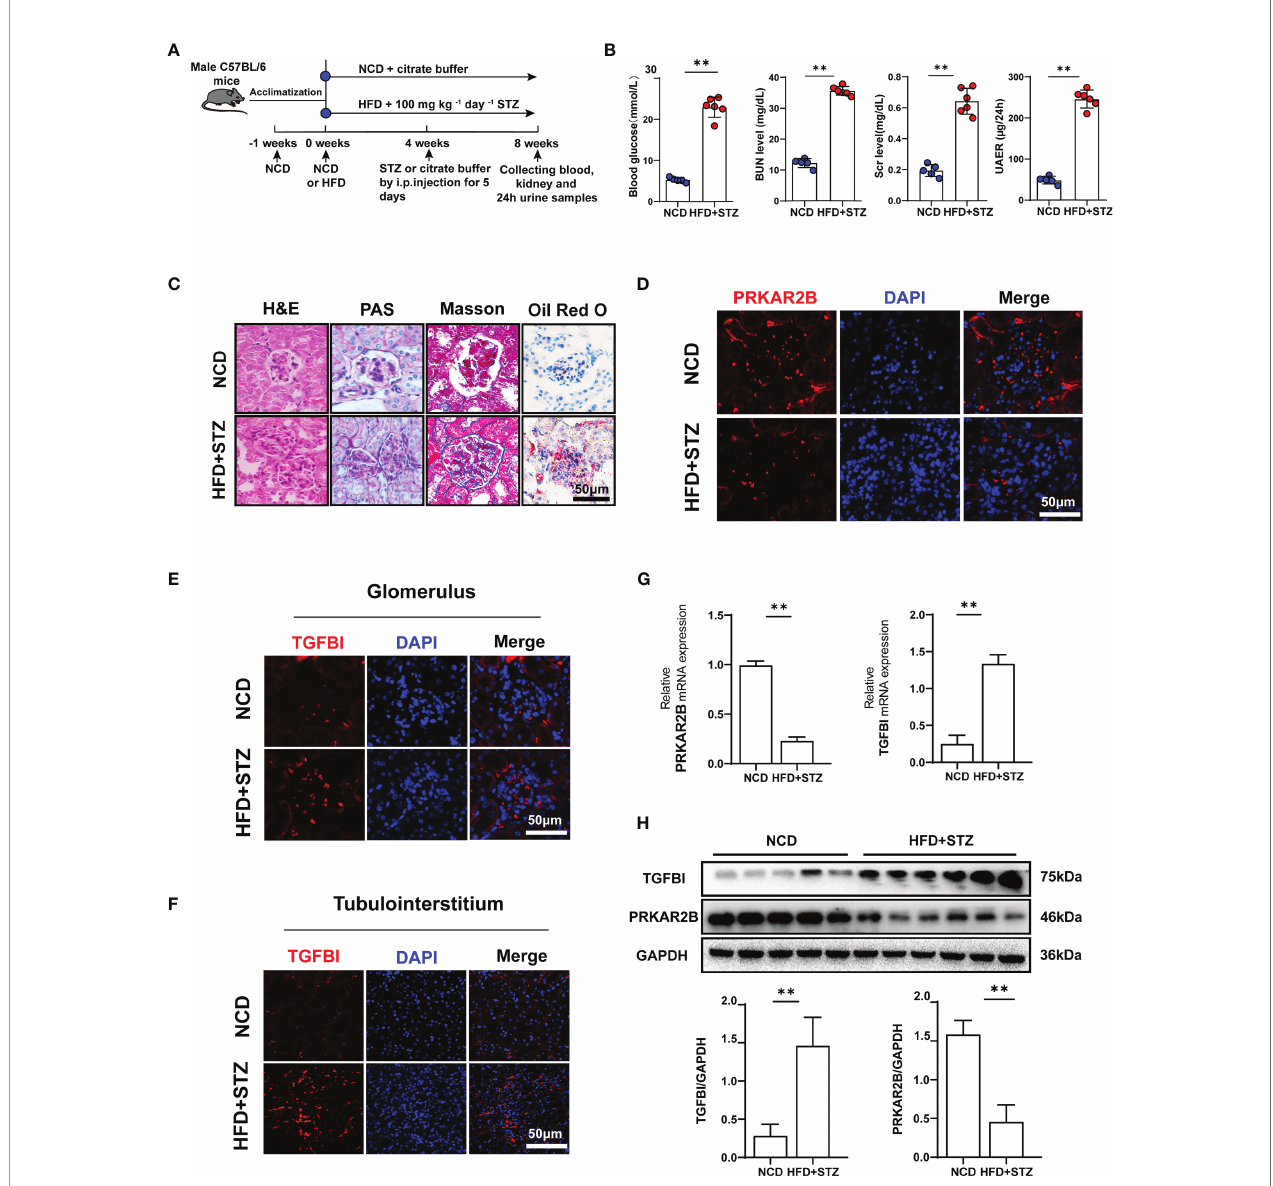
FIGURE 8 | Veri fi cation in animal experiments. (A) The treatment protocol for mouse model. (B) Blood glucose, Scr, BUN, and 24 h proteinuria levels. (C) Renal pathological sections stained with H&E, PAS, Masson, and Oil Red O. (D) Immuno fl uorescence staining of PRKAR2B in renal glomerular tissue. (E, F) Immuno fl uorescence staining of TGFBI in glomerular and tubulointerstitial tissues. (G) The mRNA expression of PRKAR2B and TGFBI in kidney tissue (RT-qPCR). (H) The protein levels of PRKAR2B and TGFBI in kidney tissue (Western blot). ** p < 0.01 vs. NCD mice. NCD, normal chow diet; HFD, high-fat diet; STZ,